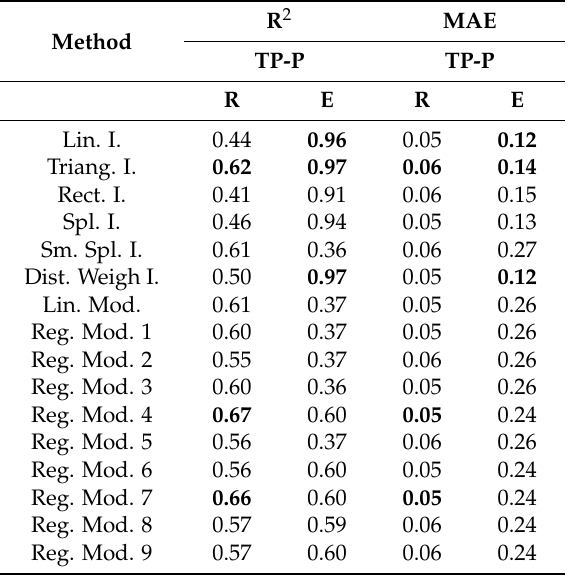
Table 4. Overview of evaluation criteria for the load calculation methods used for the fixed-schedule data set (R) and the extended data set (E). Abbreviations of the methods are explained in Table 1; MAE in (g · ha − 1 · d − 1 ); numbers in bold mark the models selected for further analysis (LF-R and LF-E).